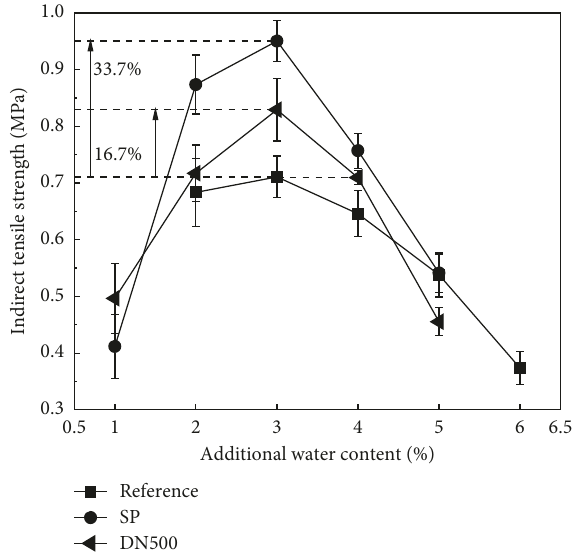
Figure 7: The ITS of CRME with different